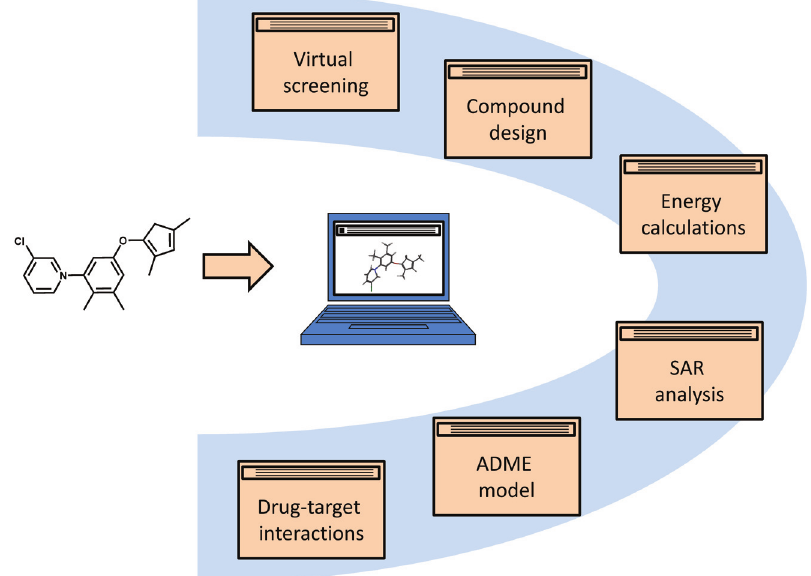
Figure 1. Areas of computer-aided drug discovery. Selected computational areas are shown providing focal points of the discussion. Each subject area covers a variety of computational approaches, as discussed in the